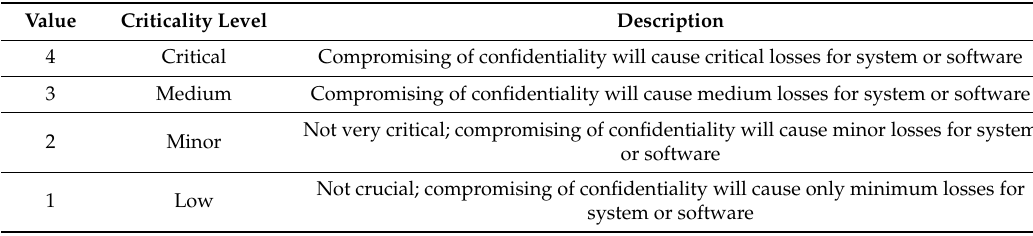
Table 4. Criticality level of data confidentiality.